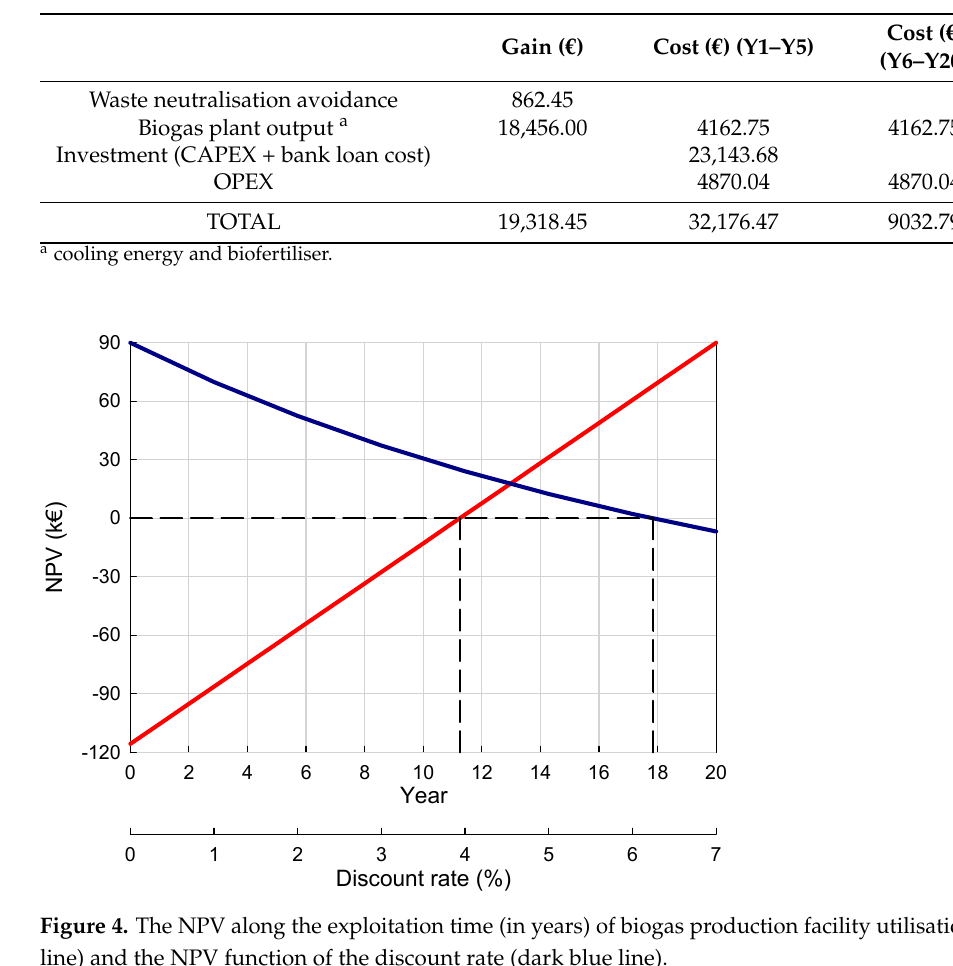
Table 5. Economic balance of biogas facility (year scale).